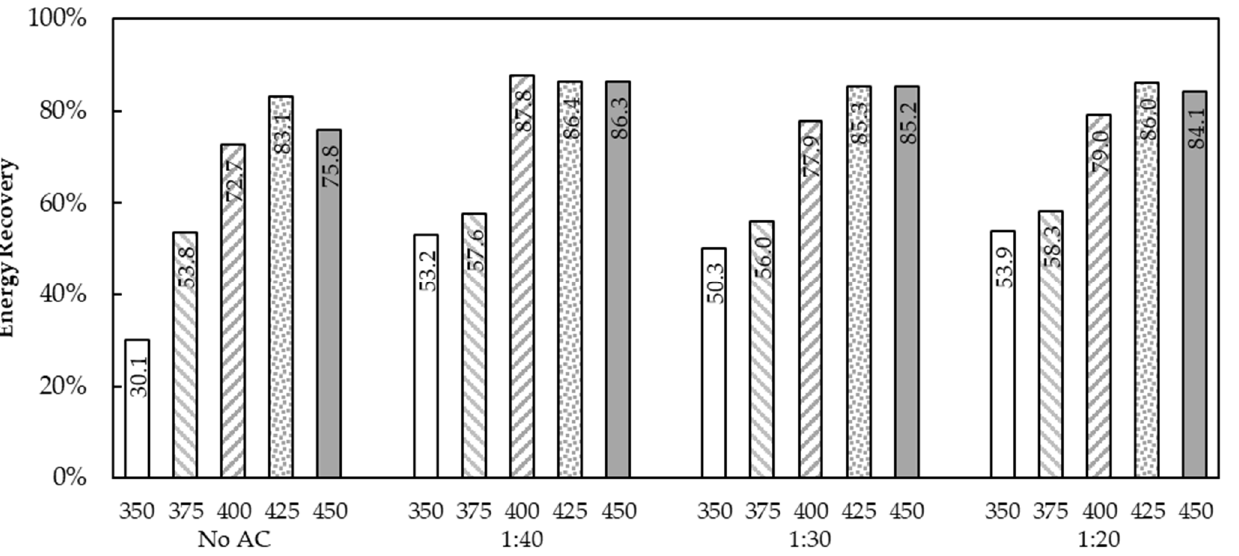
Figure 10. The energy recovery of the liquid bio-oil obtained from WCO pyrolysis.